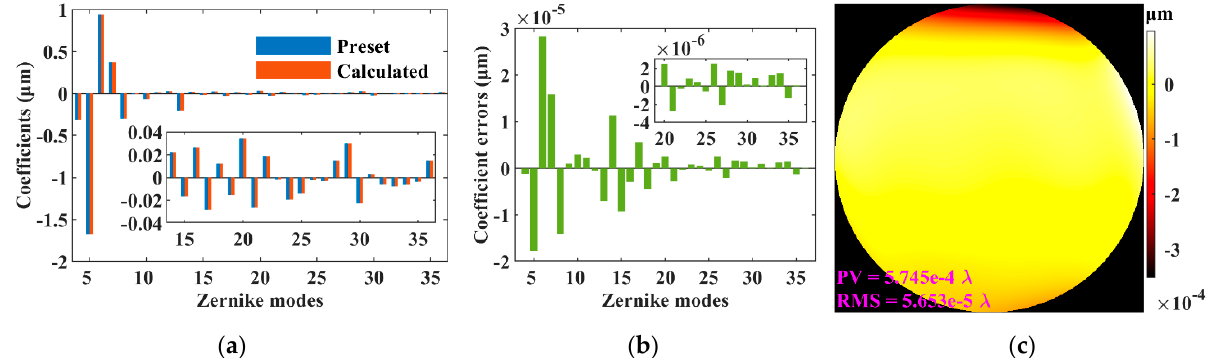
Figure 6. Results of vSHWS with optimizing parameters. ( a ) Zernike coefficients; ( b ) Zernike coefficient errors; ( c ) wave-